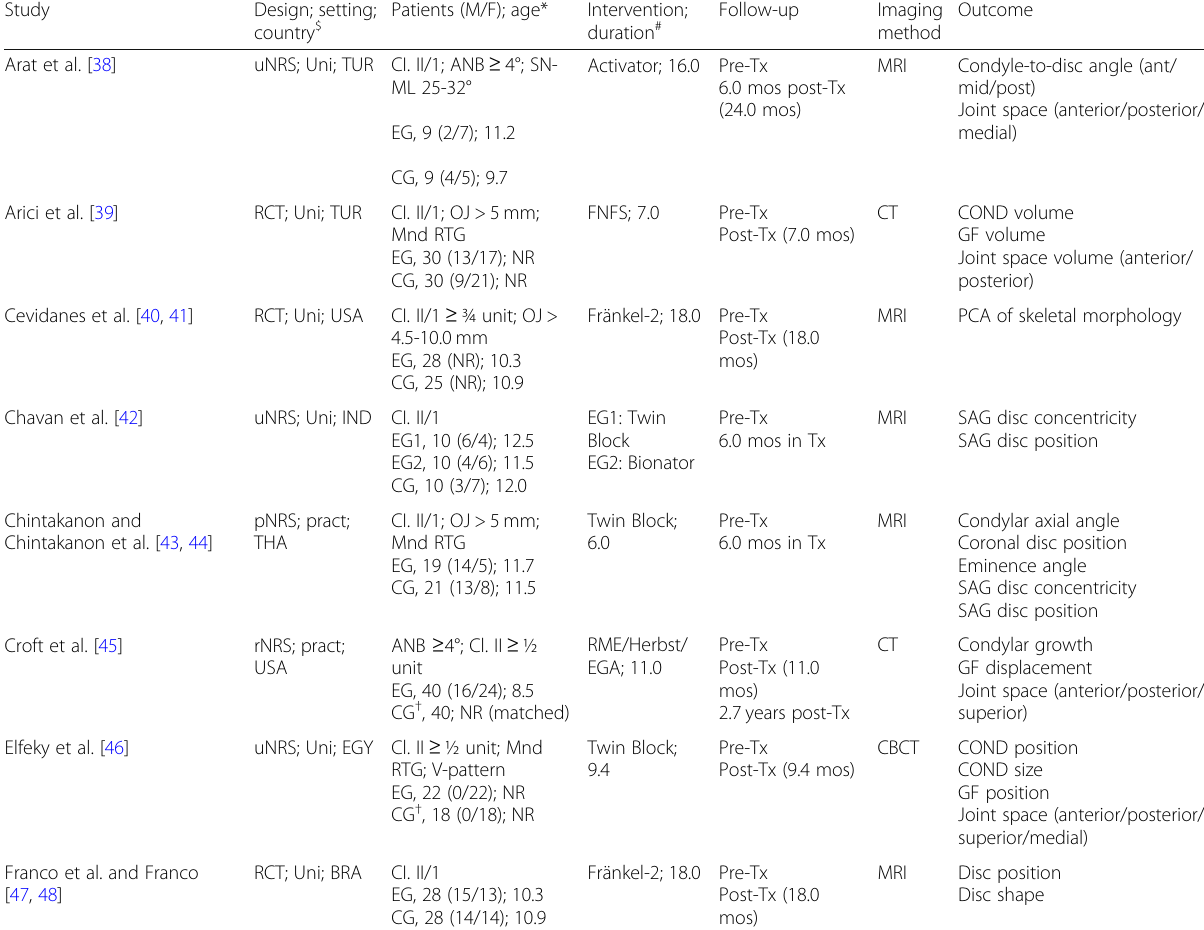
Table 1 Characteristics of included studies Study Design; setting; country